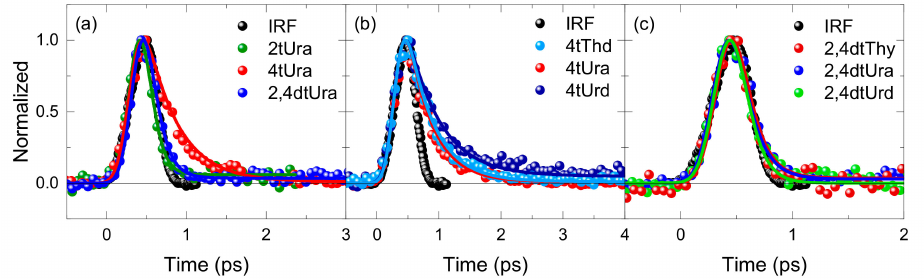
Figure 3. Fluorescence up conversion data for ( a ) 2-thiouracil, 4-thiouracil, and 2,4-dithiouracil, ( b ) 4-thiopyrimidines, and ( c ) 2,4-dithiopyrimidines in acetonitrile at the emission wavelength of 380 nm upon excitation of the thiobase monomers at 267